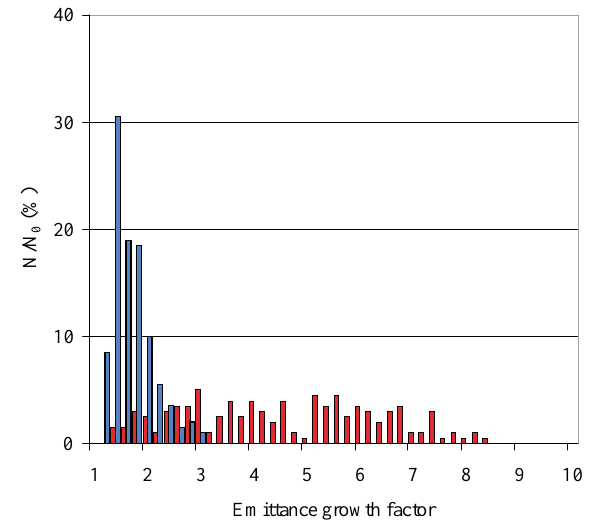
FIG. 12. (Color) Emittance growth in the misaligned focusing channel with m (cid:1) 60 ± . Vertical axis is a percentage of simulations with the indicated emittance growth, N 0 (cid:1) 200 . The blue bars show a case with the beam steering; the red bars show a case without